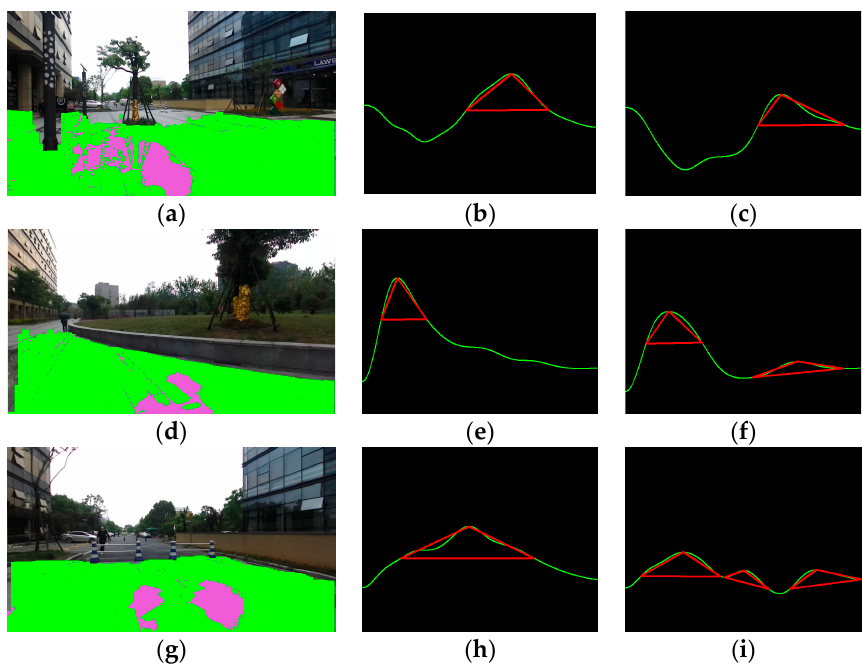
Figure 7. Farthest traversable lines with or without water hazard detection. ( a , d , g ) Traversable area and water hazard detection results; ( b , e , h ) Farthest traversable lines correspond to the traversable area detection without water hazard detection; ( c , f , i ) Farthest traversable lines obtained with both traversable area detection and water hazard detection.